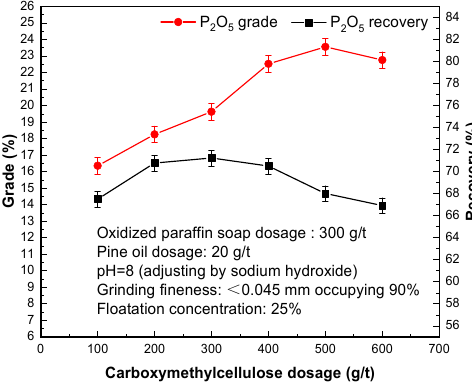
Figure 5. E ff ect of carboxymethylcellulose dosage on extracting Figure 5. Effect of carboxymethylcellulose dosage on extracting phosphorous.